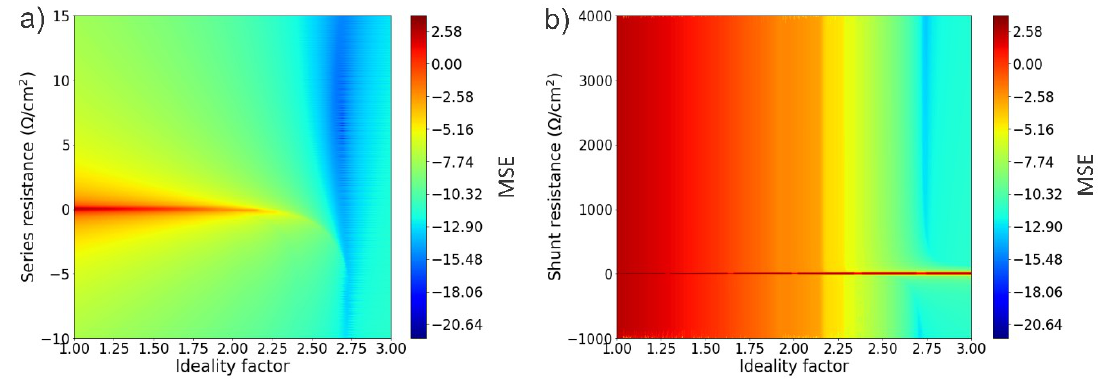
Figure 3. Mean Squared Error (MSE) behavior as function of ideality factor and series ( a ) and shunt ( b ) resistances for Cell 1. Bar on the right denotes MSE logarithm.